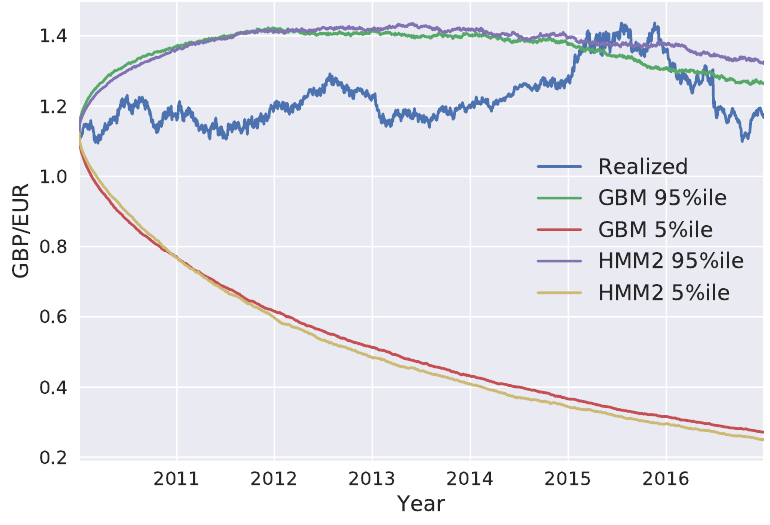
Figure 8. Percentiles of long-term distribution cones for GBP/EUR under GBM and HMM with two states.